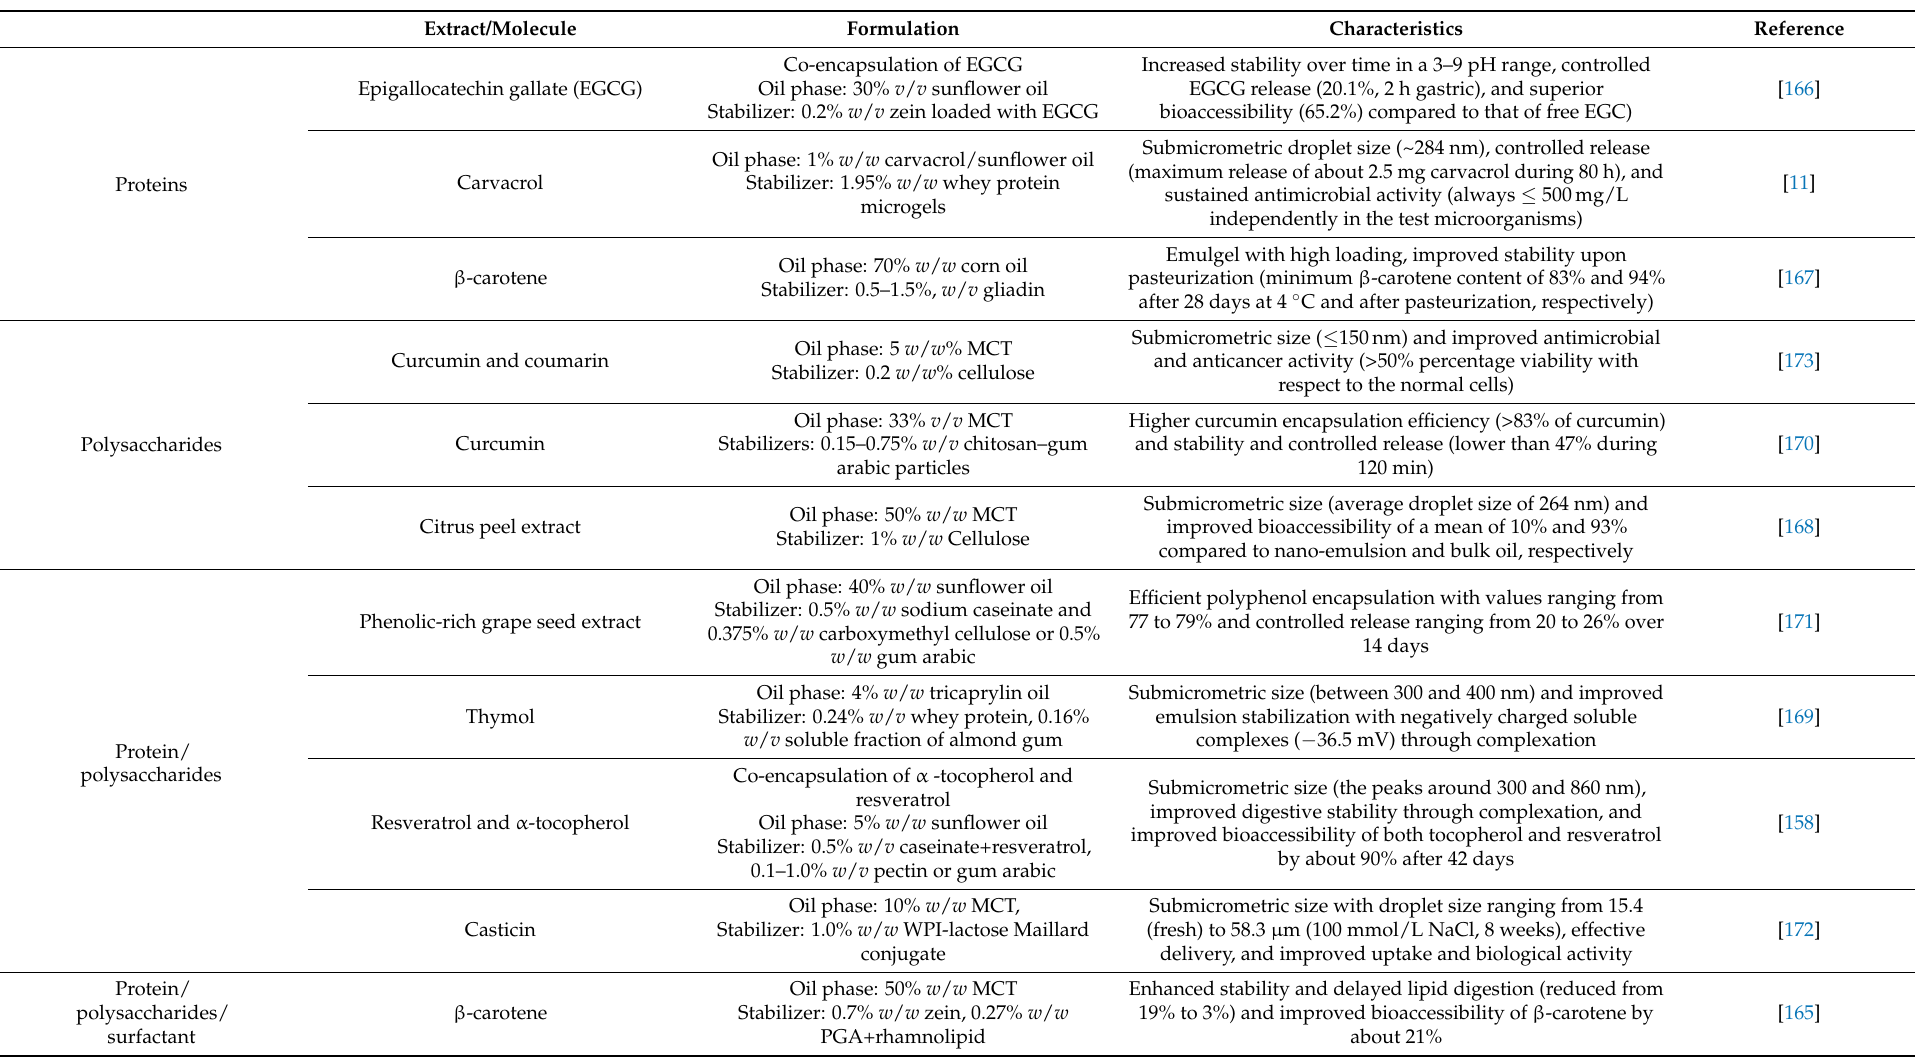
Table 3. Examples of Pickering emulsions for the encapsulation of plant extract/isolated